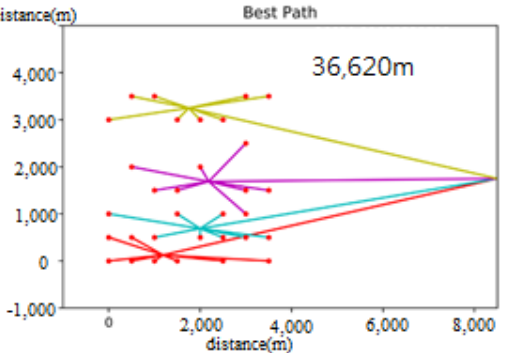
Figure 15. Optimal cable layout using radial connection mode.